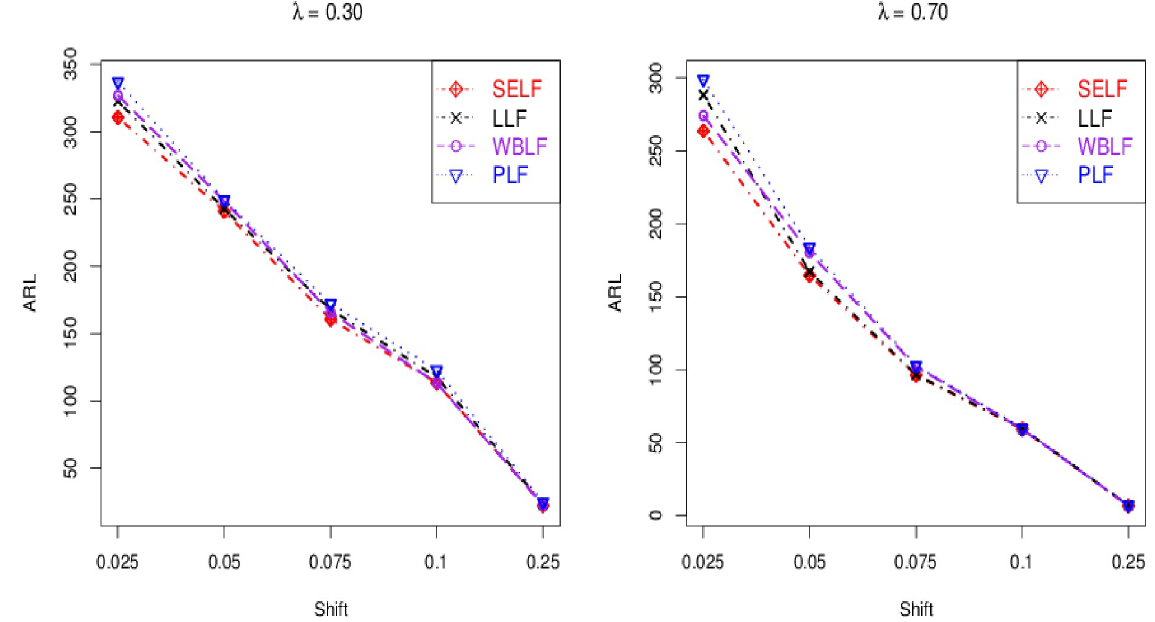
Fig 2. ARL curves for n = 20 and ARL 0 = 370 under different loss functions for fixed smoothing constant λ .